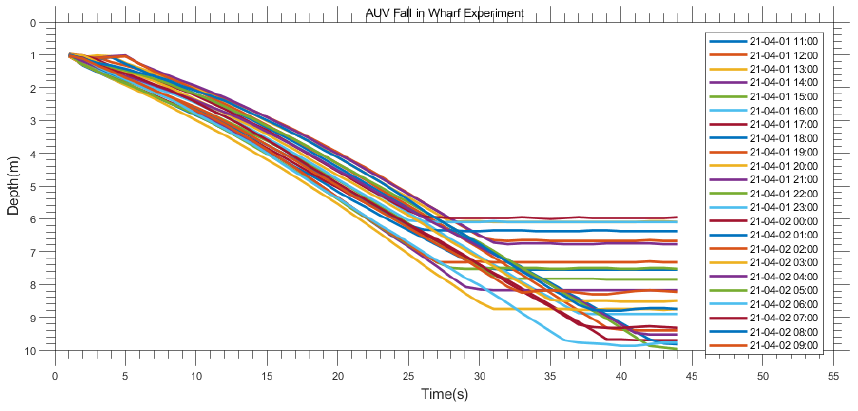
Figure 15. Experimental results at the wharf.